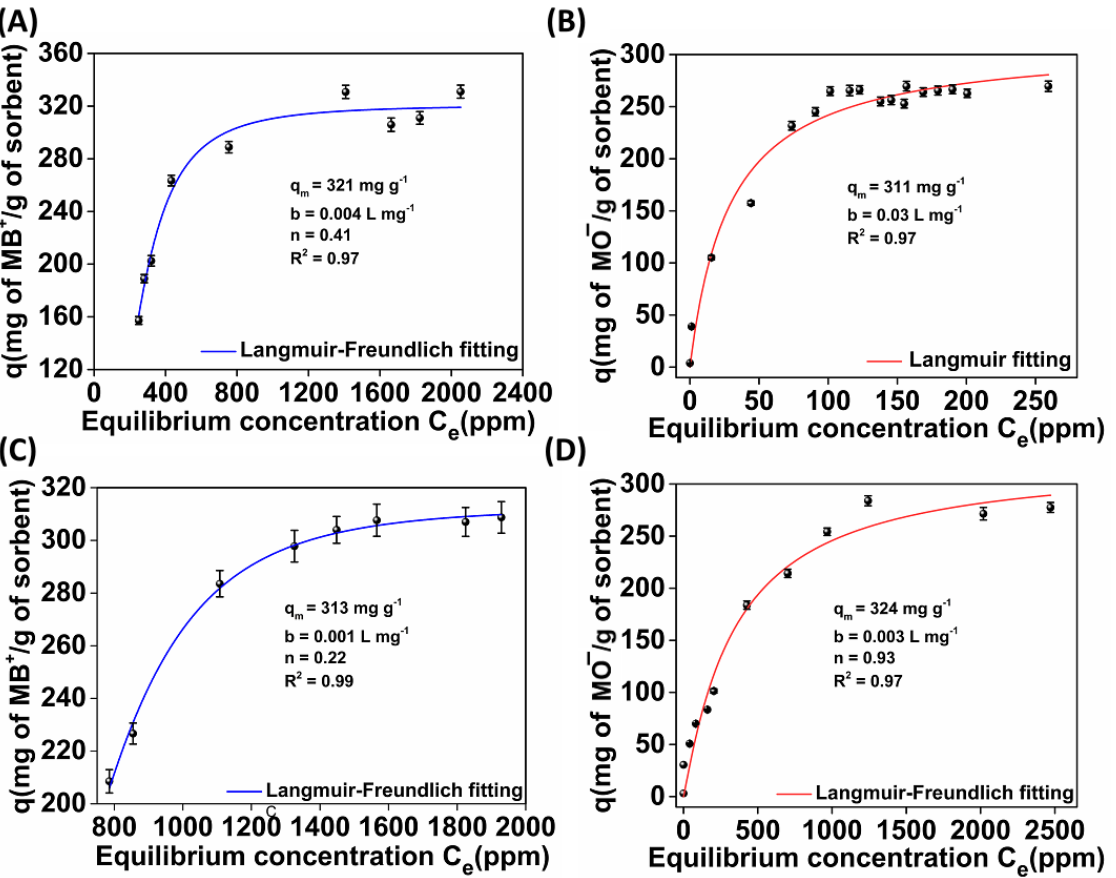
Figure 7. ( A ) MB + and ( B ) MO − isotherm sorption data for (MOR-1/Bentonite)-HA ; ( C ) MB + and ( D ) MO − isotherm sorption data for (MOR-1/Clinoptilolite)-HA.